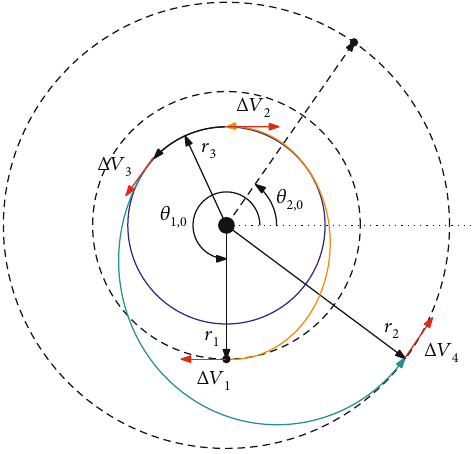
Figure 3: Chaser trajectory according to the suboptimal rendezvous strategy adopted as